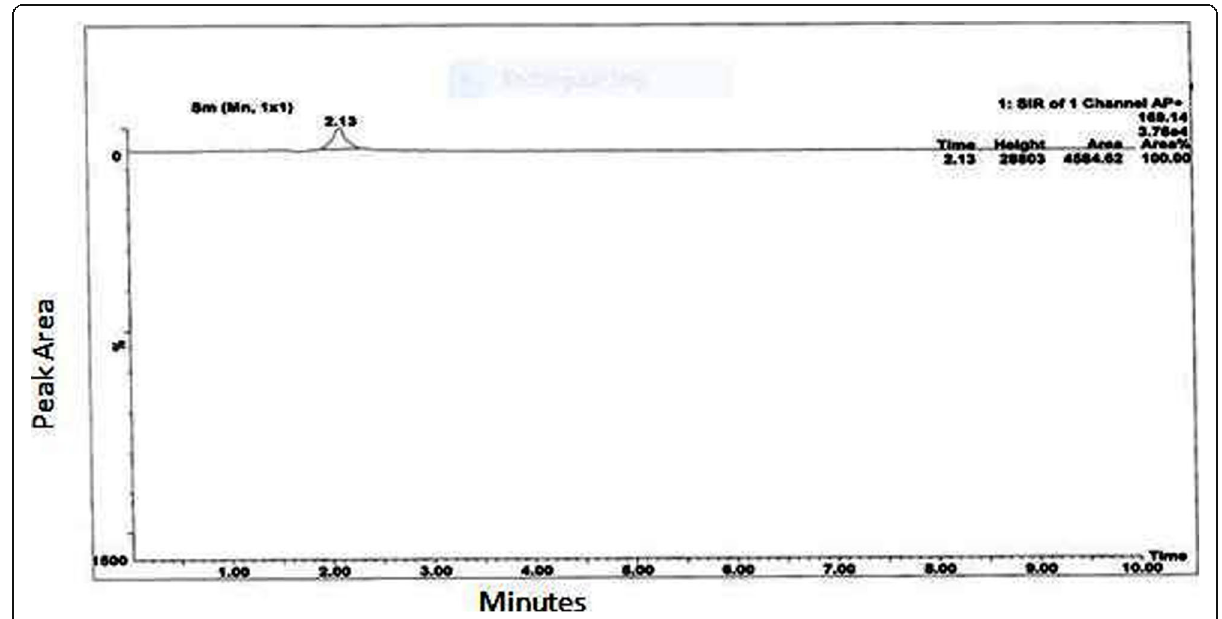
Fig. 2 Chromatogram of phenyl vinyl sulfone